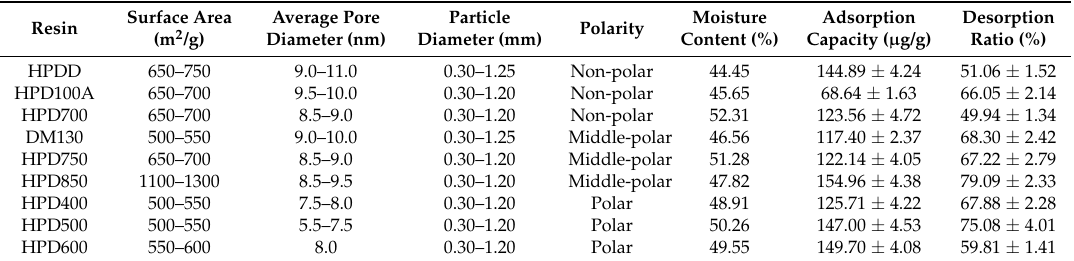
Table 1. Physical properties and absorption characteristics of the macroporous resins